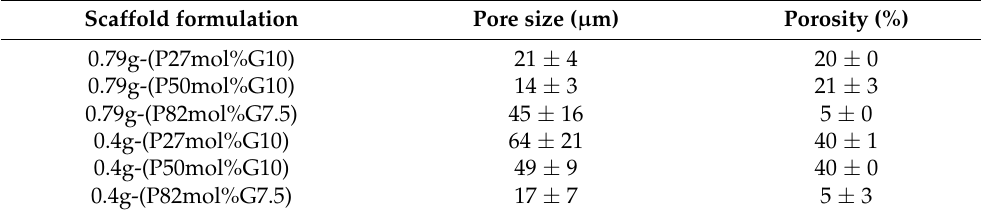
Table 2. The pore size and porosity of P(3HB- co -4HB)/gelatine blend scaffolds at different final weight of blend